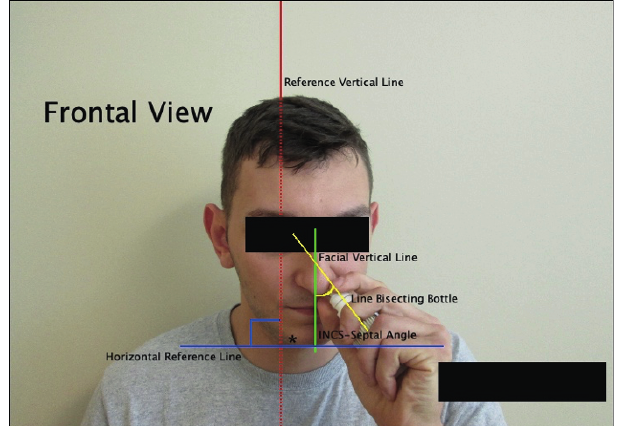
Figure 2. Photo documentation of the frontal view of a patient using spray bottle in the left naris. Frontal pictures were obtained on a wall with a vertical reference line (red). A facial vertical line (green) was then drawn from the nasion through the labrale superious (green line). A line bisecting bottle was drawn (yellow line). The INCS-Septal Angle was then calculated at the intersection of the facial vertical line and the line bisecting the bottle. The Head Frontal Tilt was calculated at the intersec- tion of the reference vertical line and the facial vertical line, where the * is located. In this figure, the reference vertical and the facial vertical lines were parallel, so the Head Frontal Tilt was 0 o